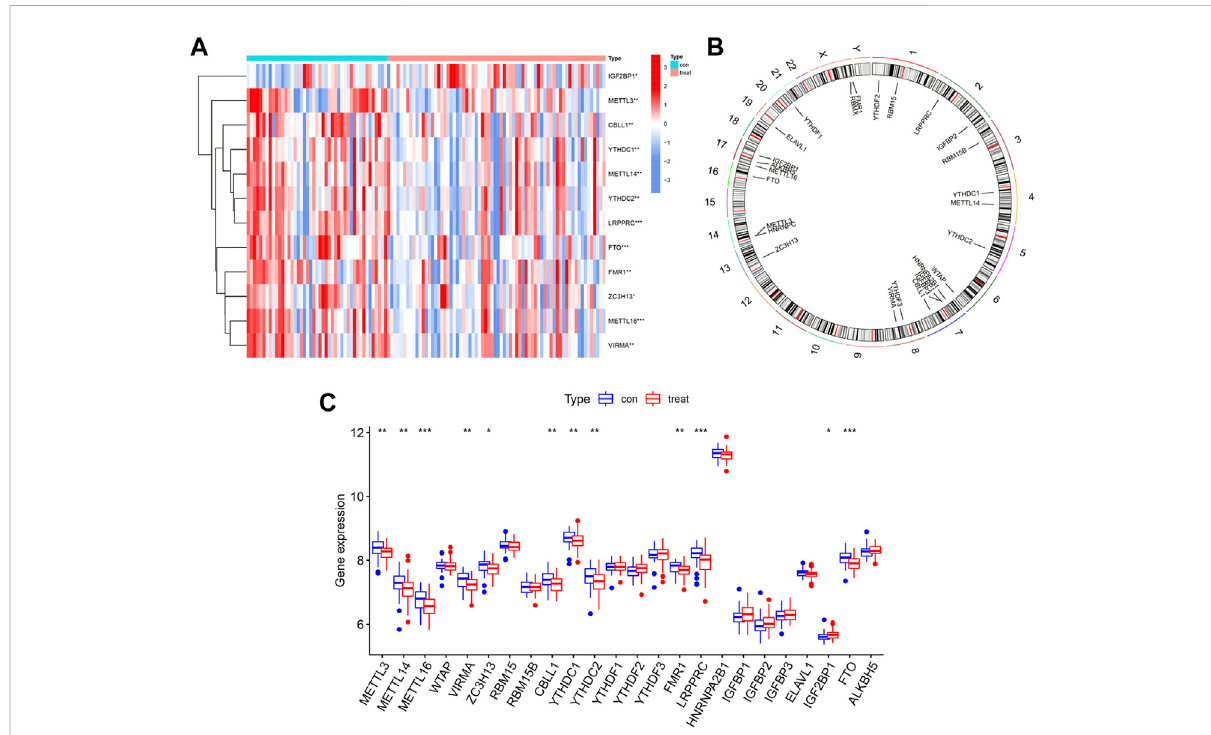
FIGURE 2 Landscape of m6A regulators in IPF. (A) Expression heatmap of 12 signi fi cant m6A regulators in healthy controls (Type: con) and IPF patients (Type: treat). (B) Chromosomal positions of the 26 m6A regulators. (C) Differential expression histogram of 12 signi fi cant m6A regulators identi fi ed between healthy controls (Type: con) and IPF patients (Type: treat). * p < 0.05, ** p < 0.01, and *** p <